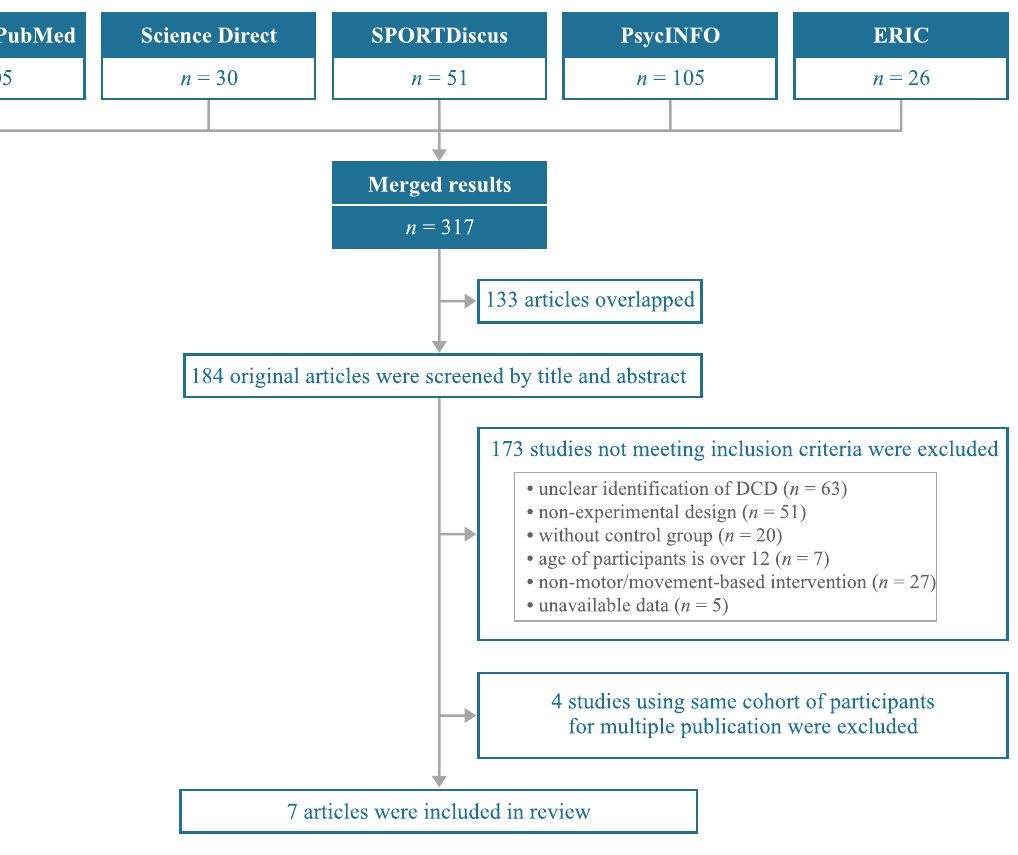
Figure 1. Flowchart of study